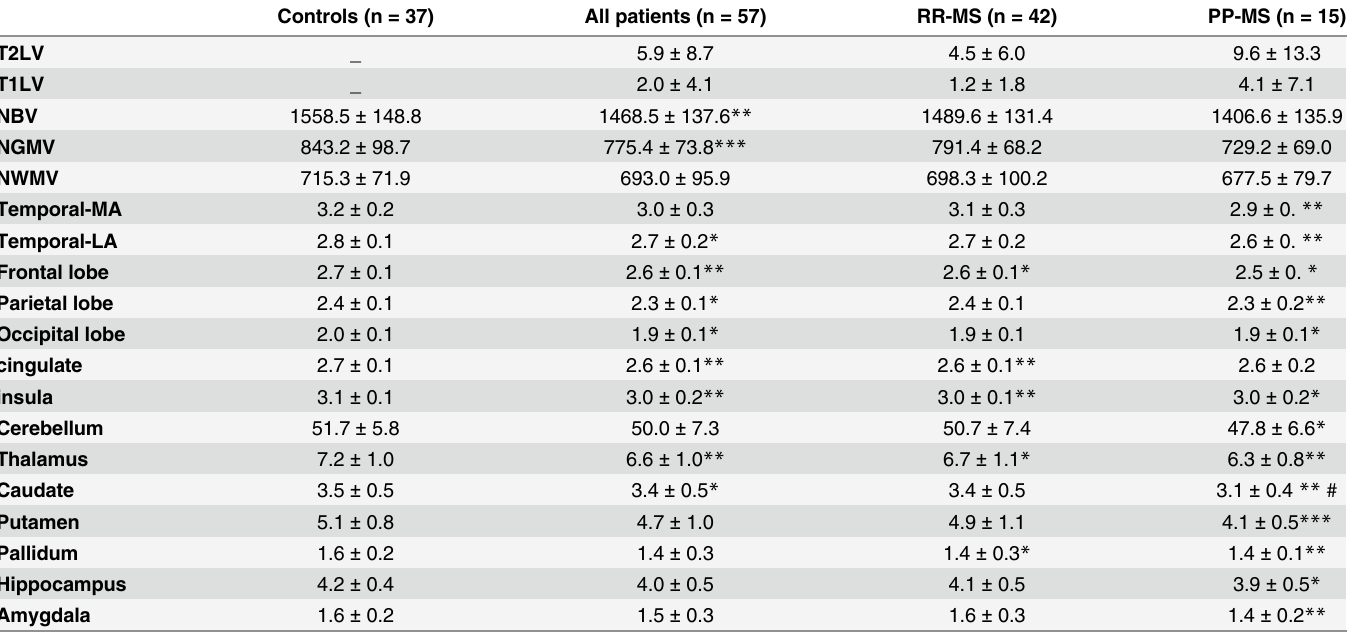
Table 3. Mean and standard deviation of MRI measures for each subject